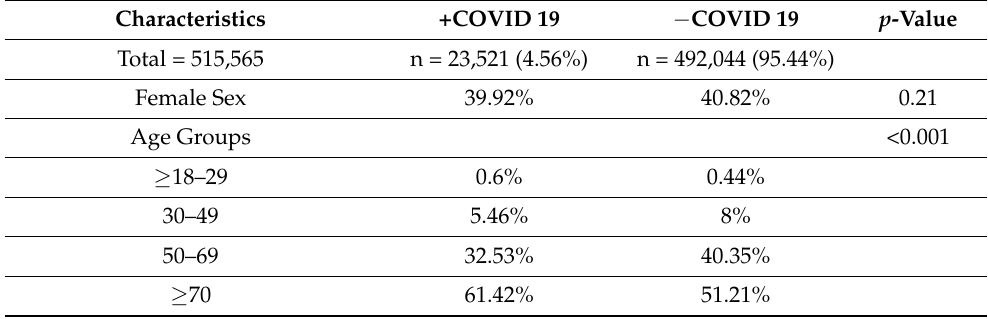
Table 1. Baseline NSTEMI Patient Characteristics Based on COVID-19